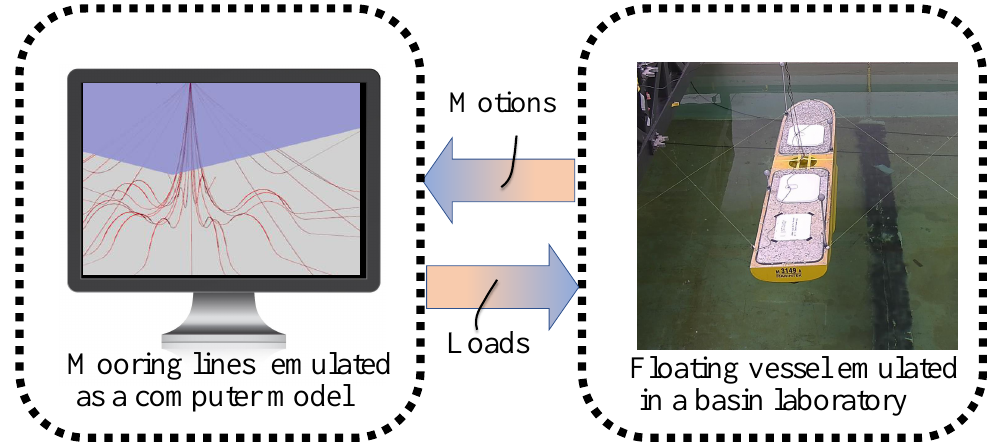
Figure 2. ReaTHM testing of a moored ship. Notice the four nylon strings used to apply the numerically calculated mooring loads onto the ship. See